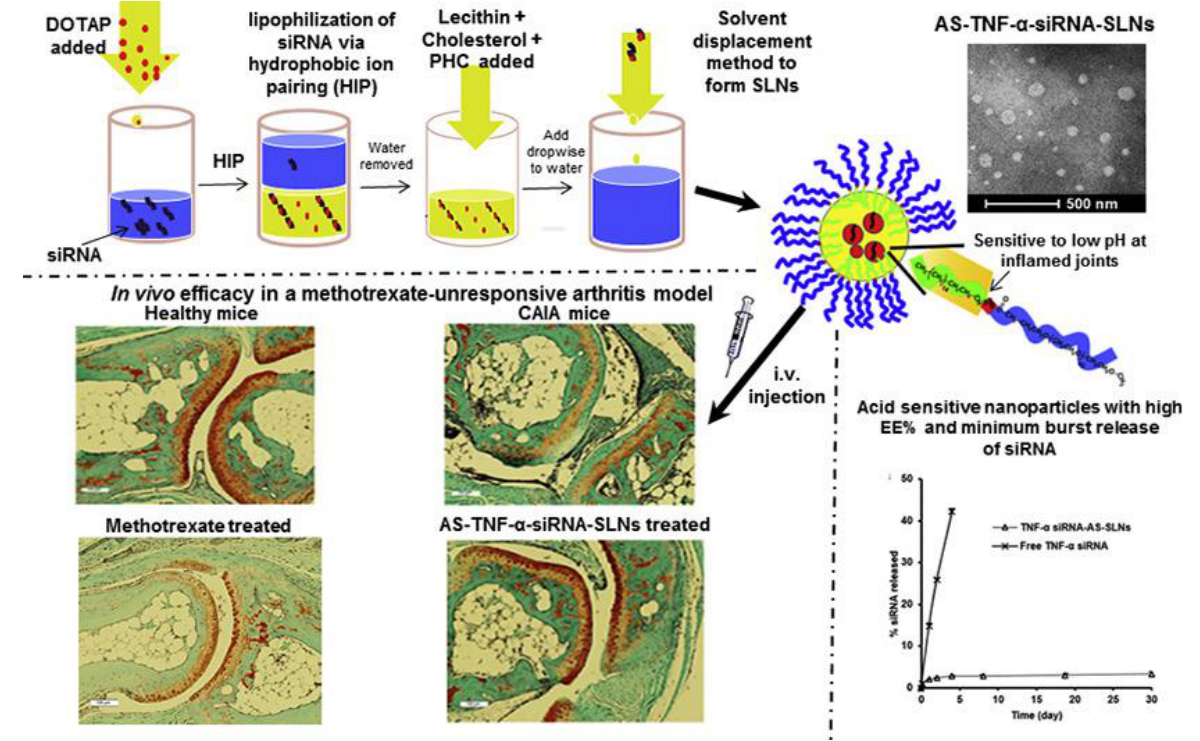
Figure 6. Schematic preparation, characterization and in vivo efficacy of AS-TNF- α -siRNA-SLNs. Reprinted with permission from Ref. [54] . Copyright © 2018 Elsevier B.V. All rights reserved.